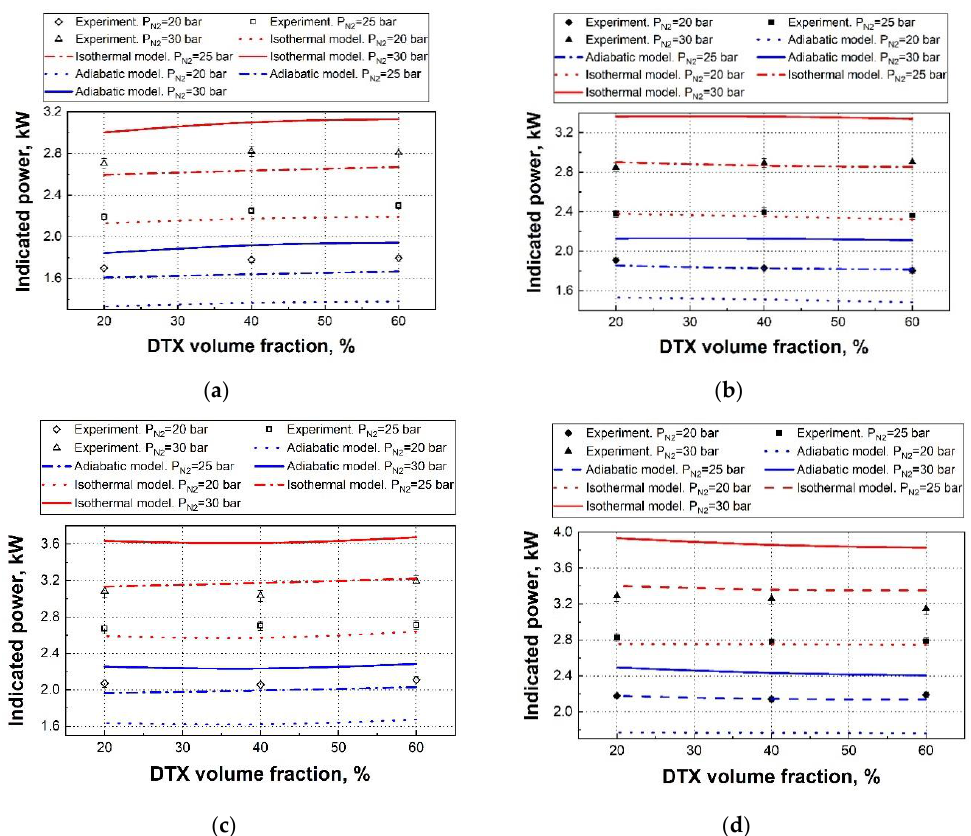
Figure 6. Comparison between experimental and modelled indicated power at different operation conditions: ( a ) 𝑁 = 600 rpm,𝑇 𝐻𝐸𝐹 = 30 °C; ( b ) 𝑁 = 600 rpm,𝑇 𝐻𝐸𝐹 = 60 °C ; ( c ) 𝑁 = 700 rpm,𝑇 𝐻𝐸𝐹 = 30 °C ; ( d ) 𝑁 = 700 rpm,𝑇 𝐻𝐸𝐹 = 60 ° C.